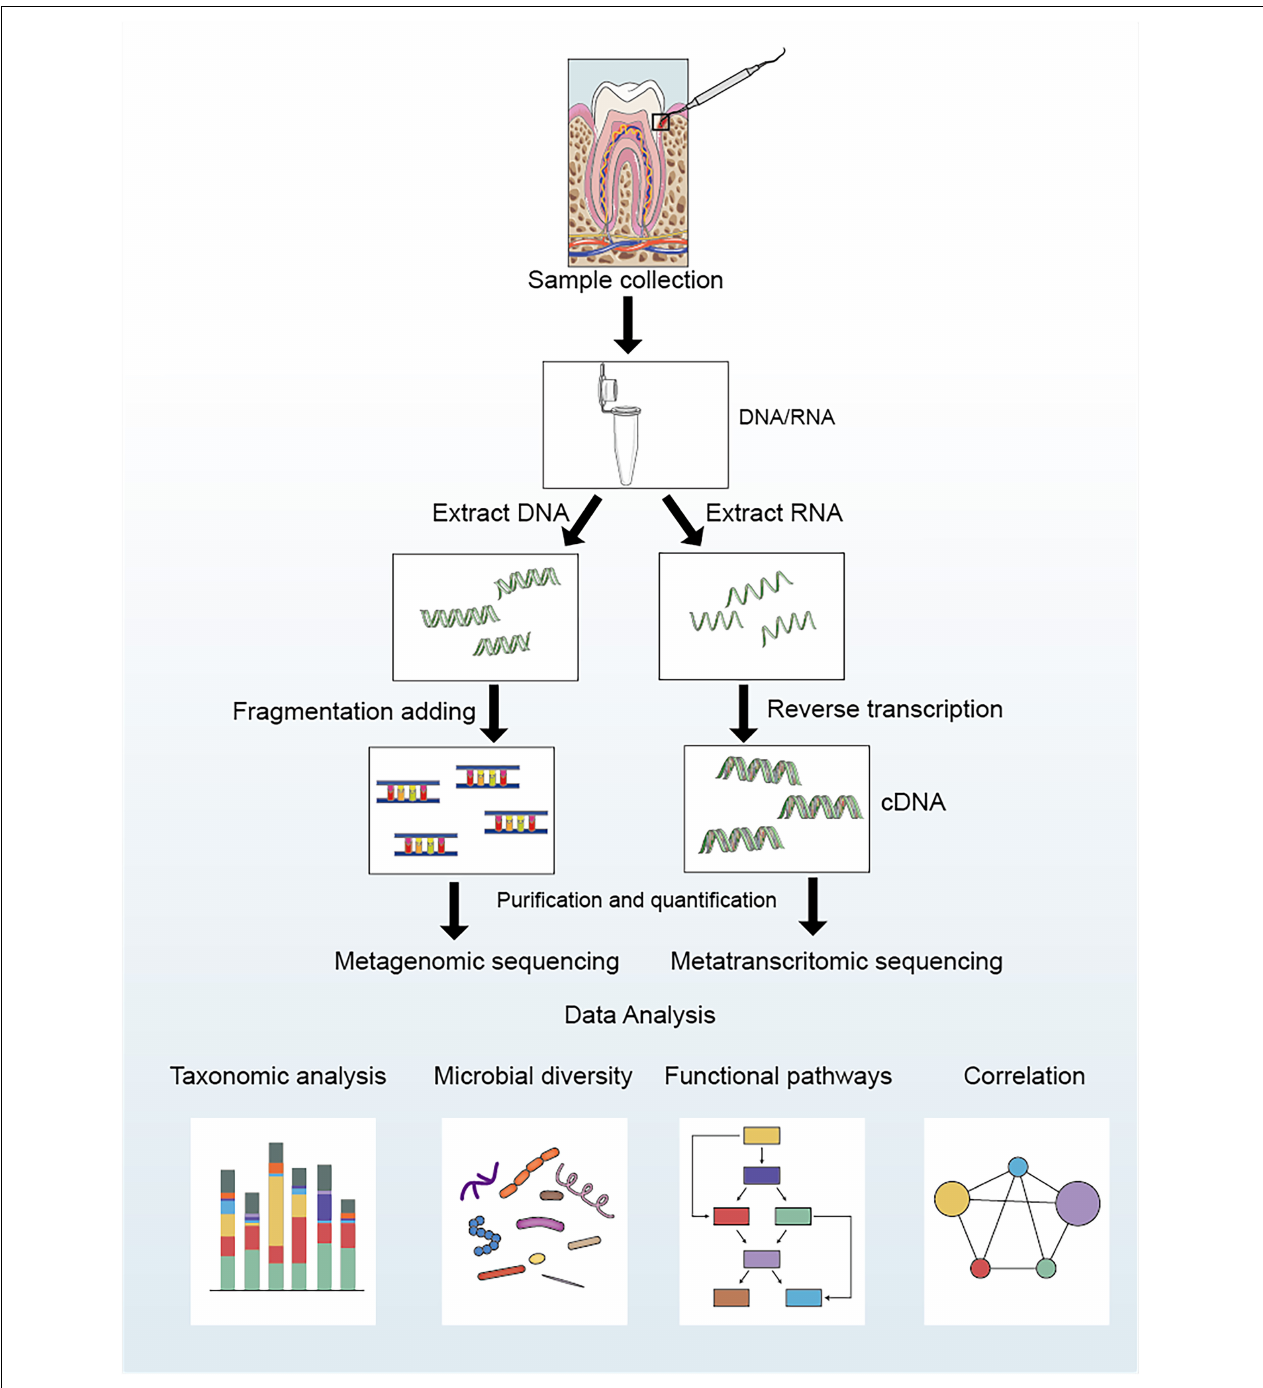
FIGURE 1 | Laboratory flow and bioinformatic analysis for metagenomic and metatranscriptomic studies of oral microbial communities.